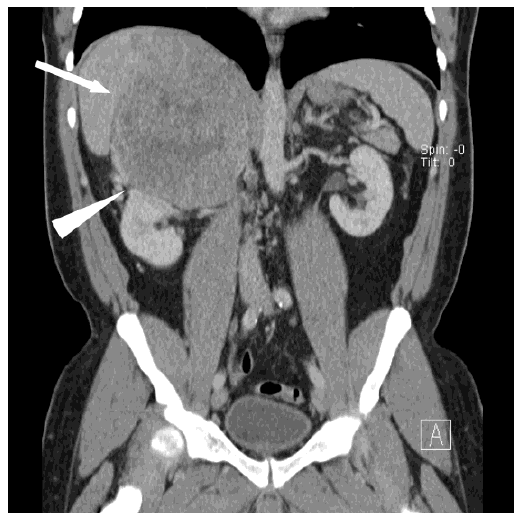
FIGURE 1. CT of large right upper quadrant mass. Arrowhead demonstrates tumor and kidney interface. Arrow demonstrates proximity/involvement of right liver.